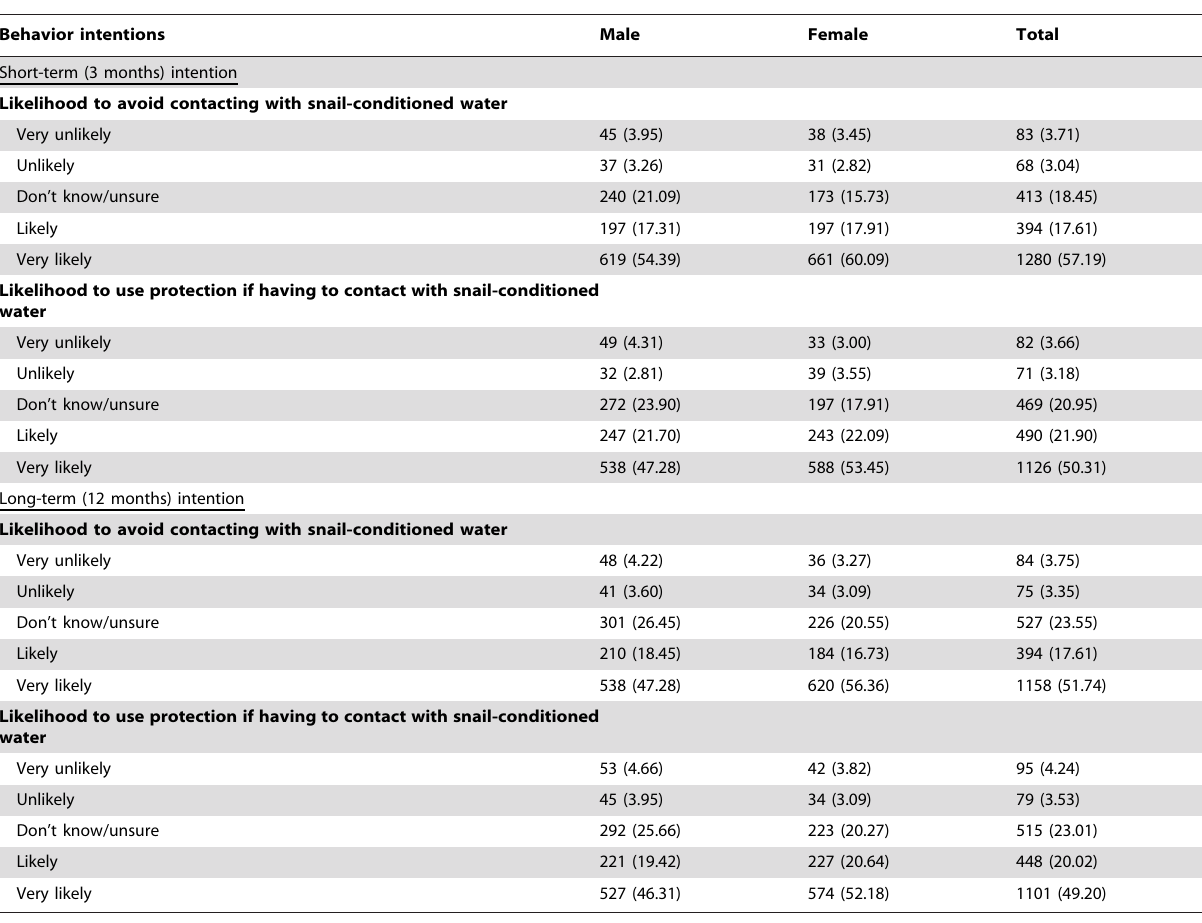
Table 3. Intention to engage in schistosomiasis protective